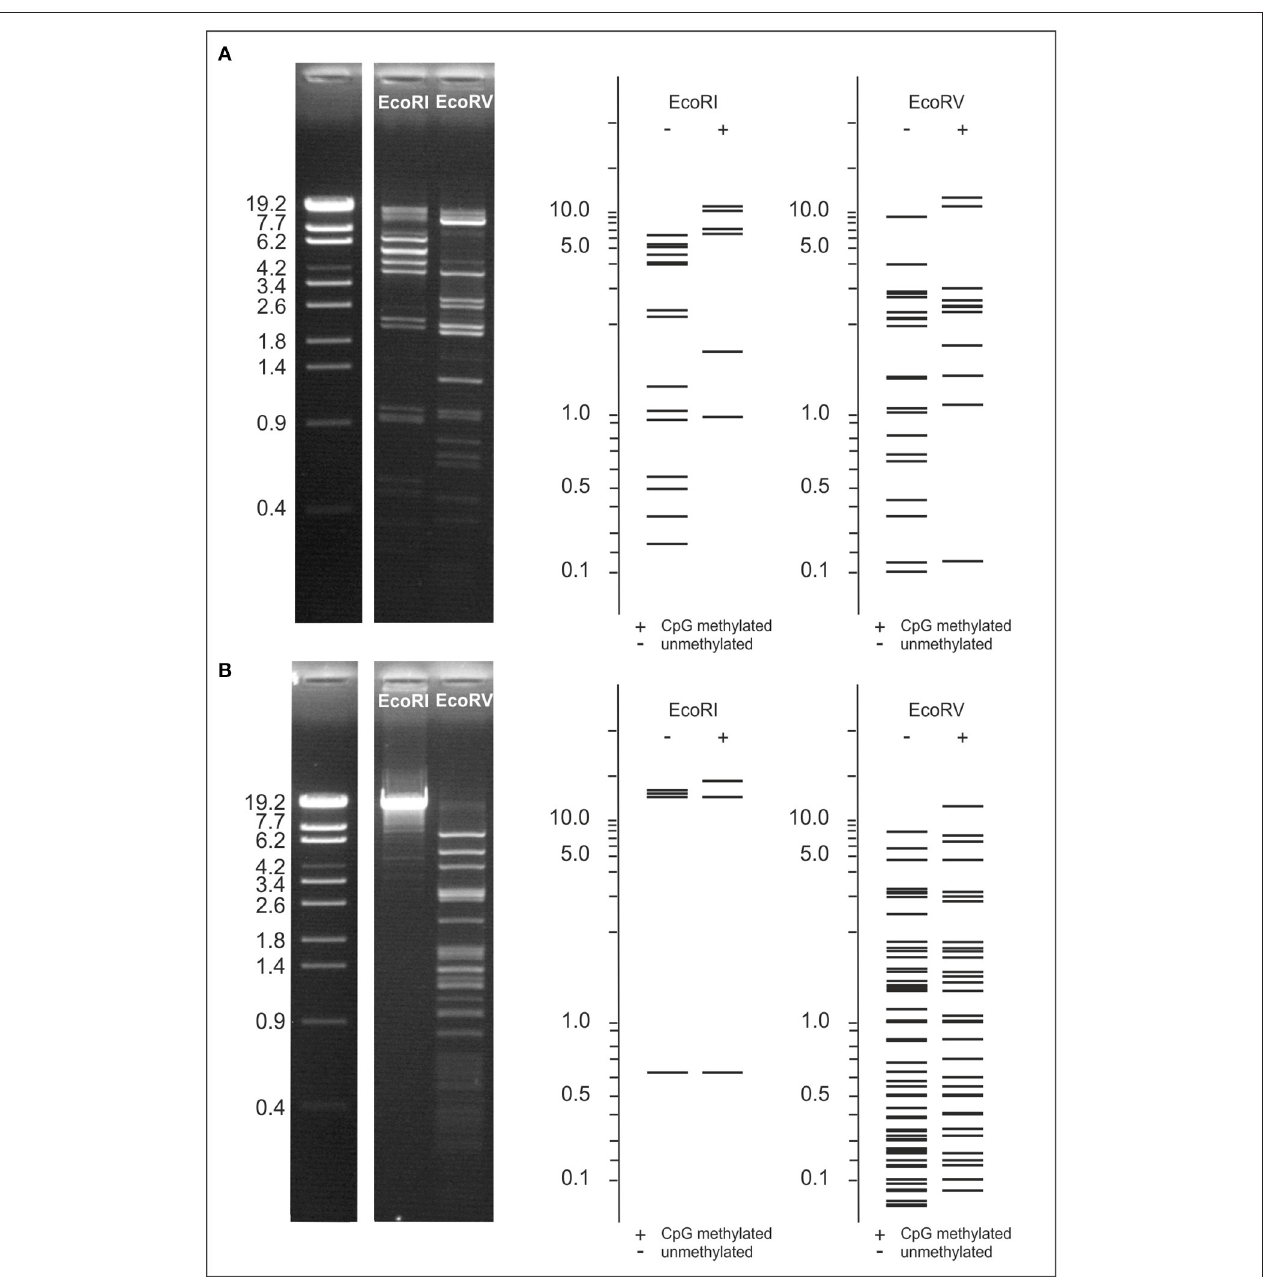
FIGURE 6 | Examination of POA1180 and POI1126 DNA modifications. To compare restriction patterns of the phages, EcoRI and EcoRV digests of POA1180 (A) and POI1126 (B) were separated on 0.8% agarose gels. Sizes of restriction fragments were determined using the λ Eco130I reference marker. For both phages EcoRI and EcoRV restriction patterns were predicted by computer analysis to compare the in silico data with experimental results. Predicted restriction patterns are shown for unmethylated and CpG methylated